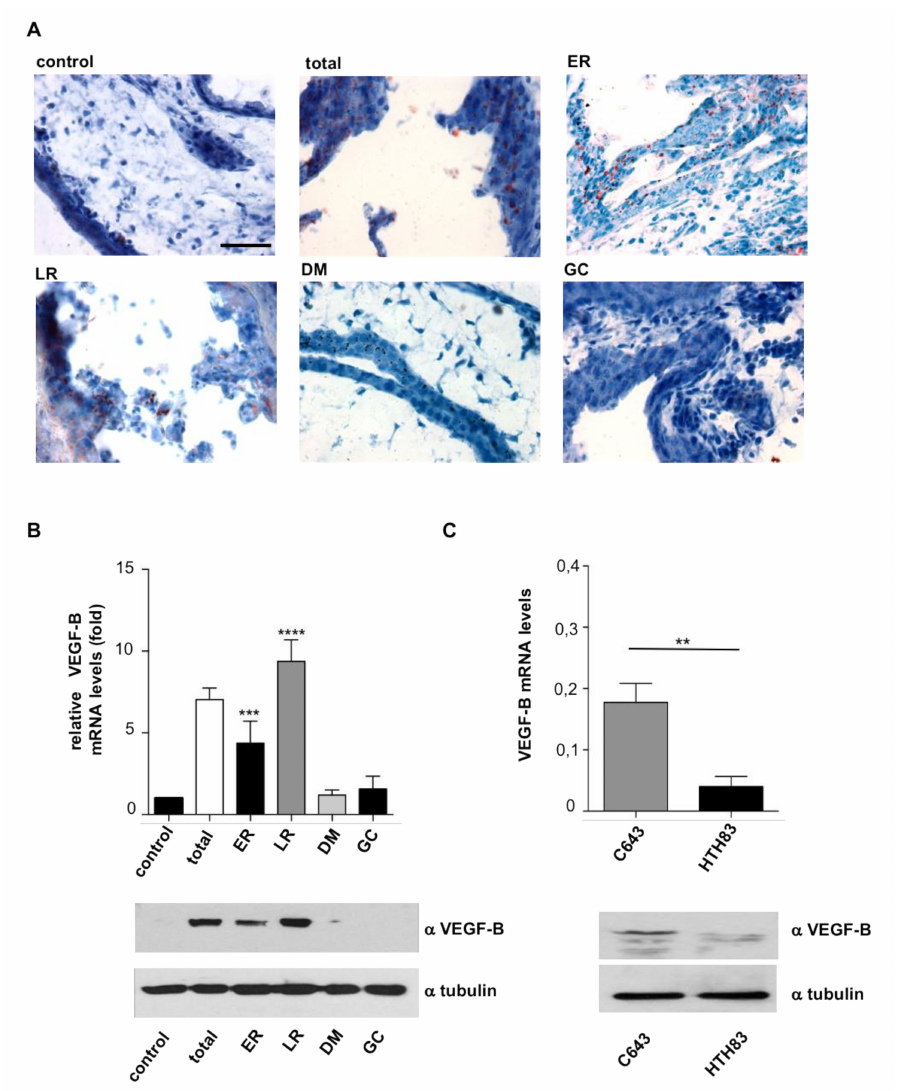
Figure 4. VEGF-B levels in relationship with HRAS sublocalization. ( A ) Lipid accumulation as unveiled by Oil Red staining in sections from tumors generated in chick embryos by the indicated HRAS V12 site-specific constructs. Scale bar = 100 µ m. ( B ) VEGF-B mRNA and protein levels in the tumors generated by the indicated HRAS V12 site-specific constructs relative to those in control cells. ( C ) VEGF-B mRNA and protein levels in tumors generated by the indicated cell lines. Data show mean ± SEM from three independent experiments using 8–10 embryos per case. ** p < 0.01 and *** p < 0.001, **** p < 0.0001 by two-tailed unpaired Student t